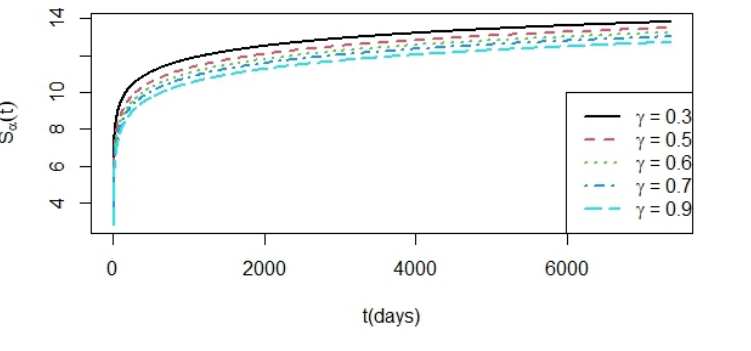
Figure 4. The entropy analysis for the DJIA at different values of γ when α = 0.298, 0.459, 0.634, 0.441 and 0.809, based on gamma, there is a distinct monotonic relationship where the entropy increases when alpha decreases.